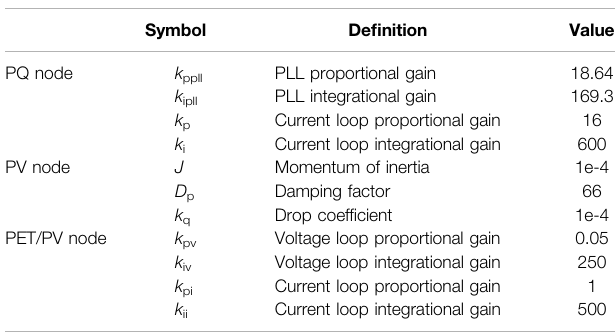
TABLE 2 | Simulation